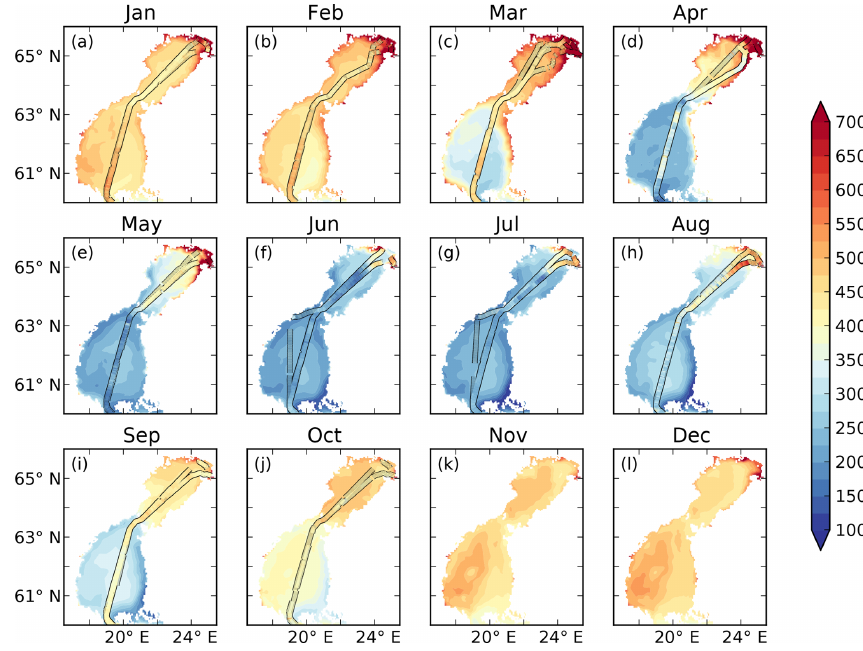
Figure 9. Observed (filled lines) and modelled (filled contours) p CO 2 (µatm) from the 1YS